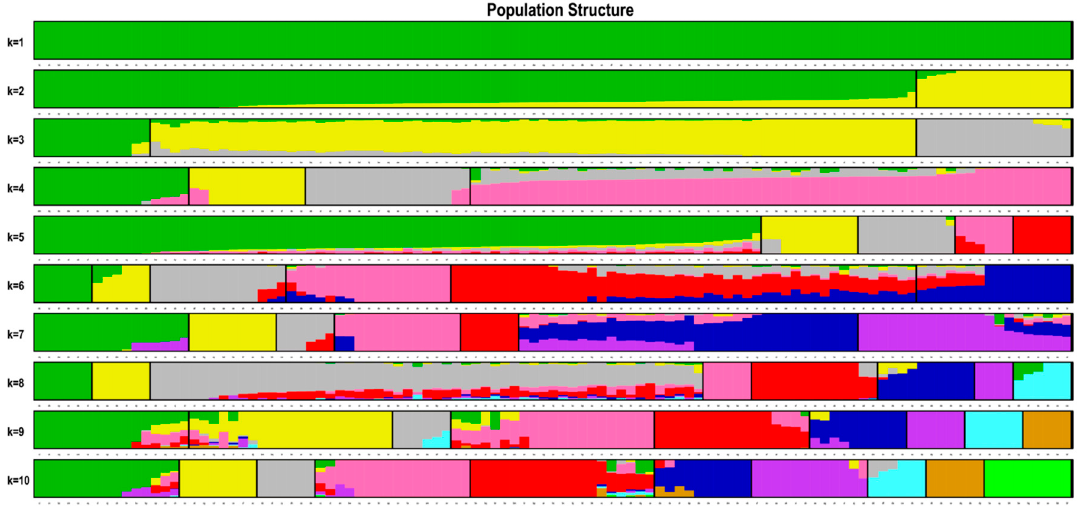
Figure 4. Population structure analysis of the 107 individuals based on 457,888 SNPs. The bars in the x-axis indicate different individuals. Colors in each row represent structural components.